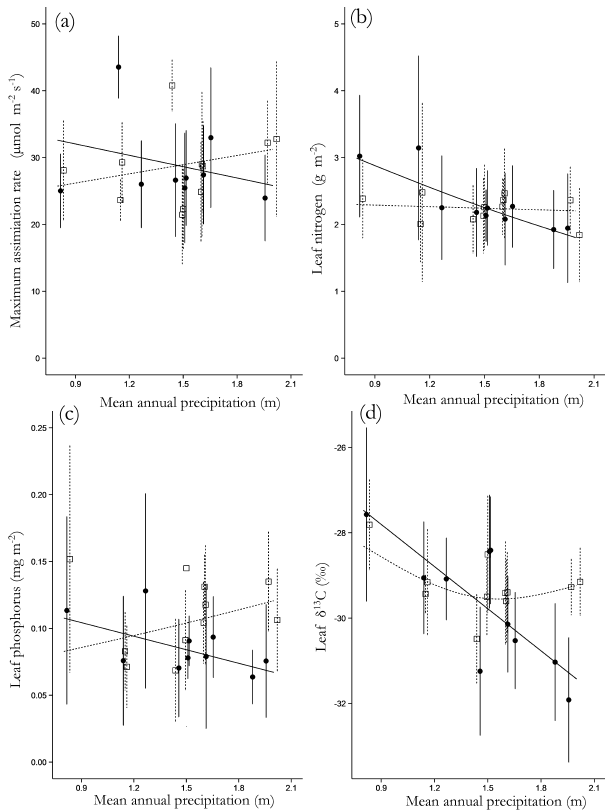
Figure 10. Variations in community-abundance-weighted mean fo- liar properties in relation to precipitation and vegetation formation type (a) light and CO 2 saturated (maximum) CO 2 assimilation rate, (b) leaf nitrogen (area basis), (c) leaf phosphorus (area basis) and (d) leaf 13 C / 12 C composition. ( • ) Forest plots; ( (cid:3) ) savanna plots. Fitted curves (solid for forest plots, dashed for savanna) represent generalised additive model fits. Error bars represent community- abundance-weighted